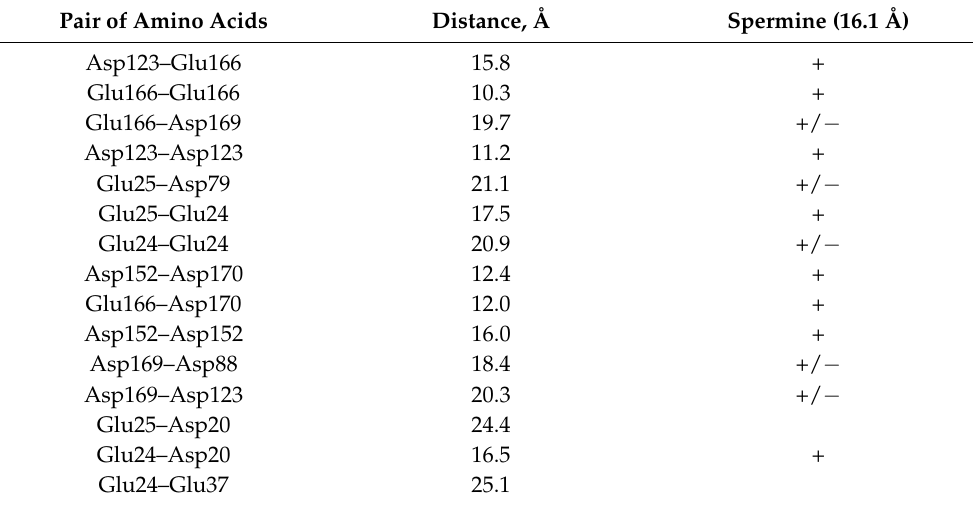
Table 5. Interatomic distances between Asp and Glu residues for the RrA subunits. Pairs of amino acids that can potentially form two-point cross-links are marked with “+”. The pairs that turn out to be closest to spermine as a result of docking are highlighted in